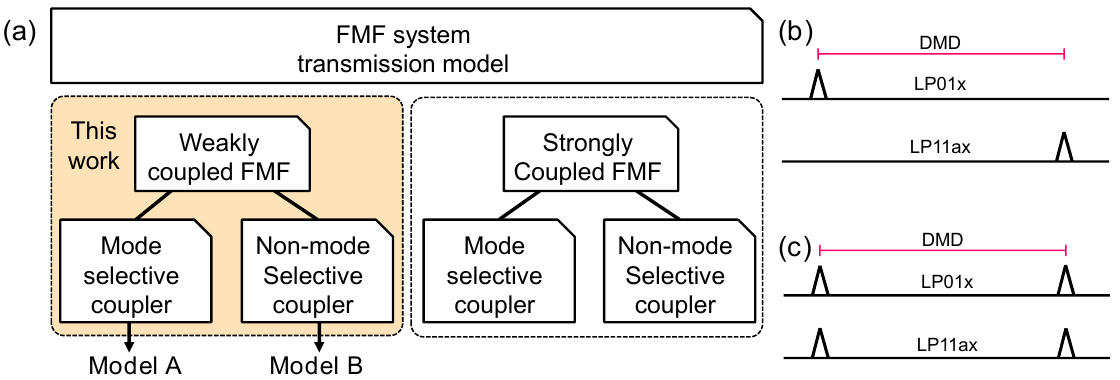
Figure 2. ( a ) Diagram of the simple modeling cases in an FMF transmission system. ( b ) Simplified weakly-coupled FMF impulse response when there is no mode mixing in the fiber and mode-selective DE/MUXes are used (model A). Differential mode delay (DMD). ( c ) Weakly-coupled FMF frequency response with non-mode-selective DE/MUXes (model B). On both examples ( b , c ), only the X polarization for LP 01 and LP a 11 modes is plotted for